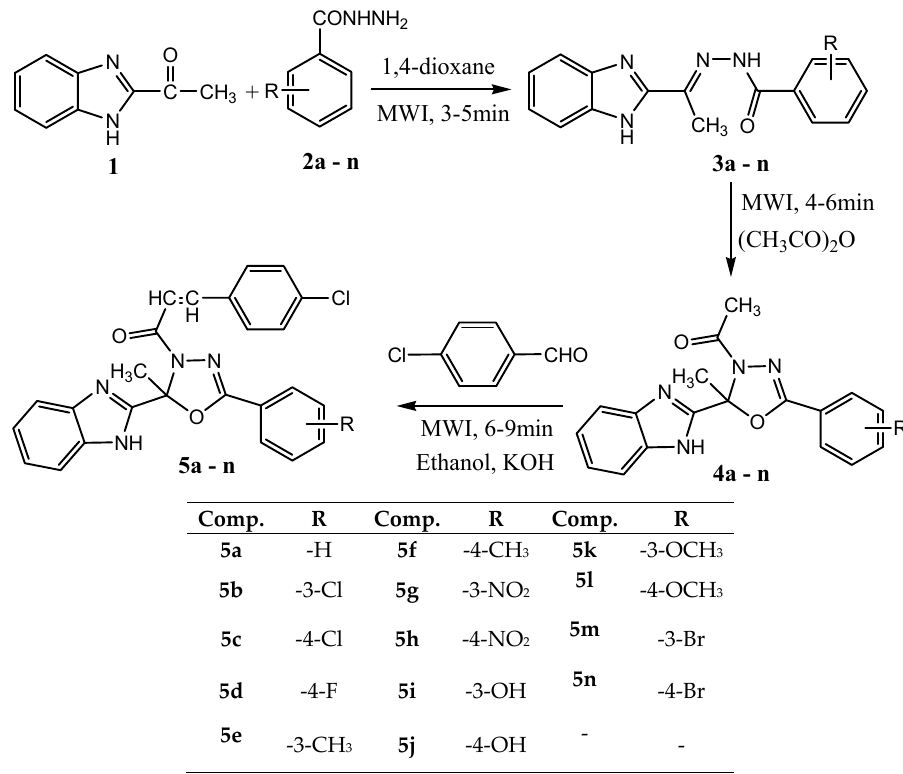
Scheme 17. Synthetic route for the preparation of title compounds ( 5a–n